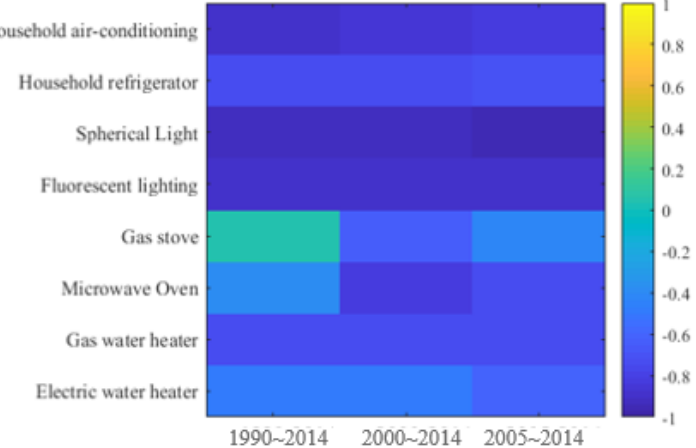
Figure 12. Correlation between equipment energy efficiency improvement and CO 2 emission of residential in different stages.